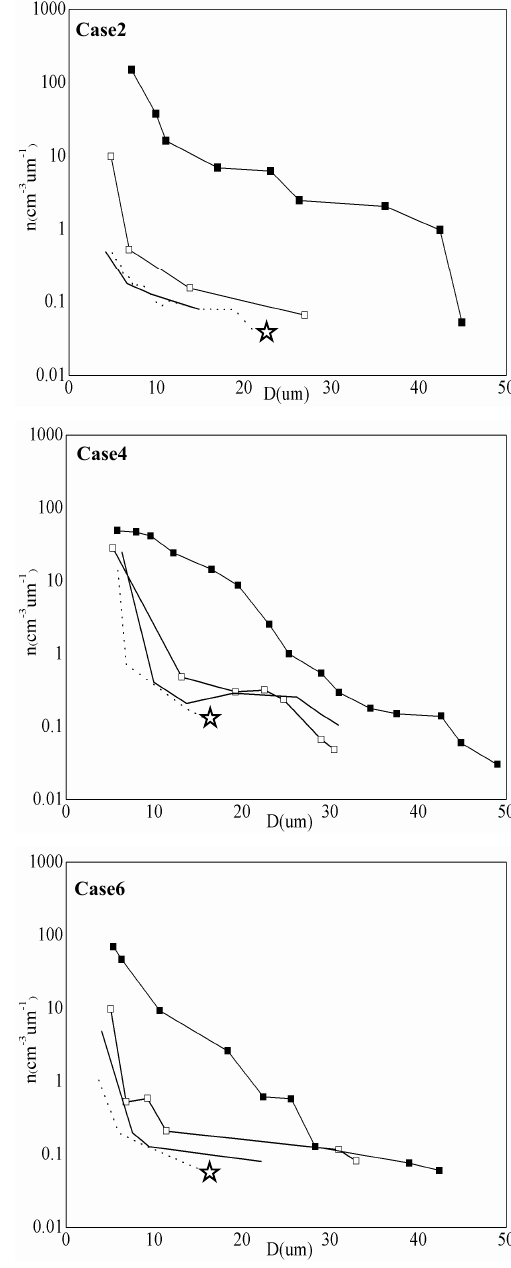
Figure 6. Fog droplet size distributions of (strong) dense fog in four stages and the D max during the formation stage. (The four phases are formation, development, maturation and dissipation. Case1, 3, 4, 5, 6 are dense fog. Case 2 is strong dense fog. The star in each plot denotes the size of the largest droplet and the corresponding N during the formation stage for the respective fog process ) .